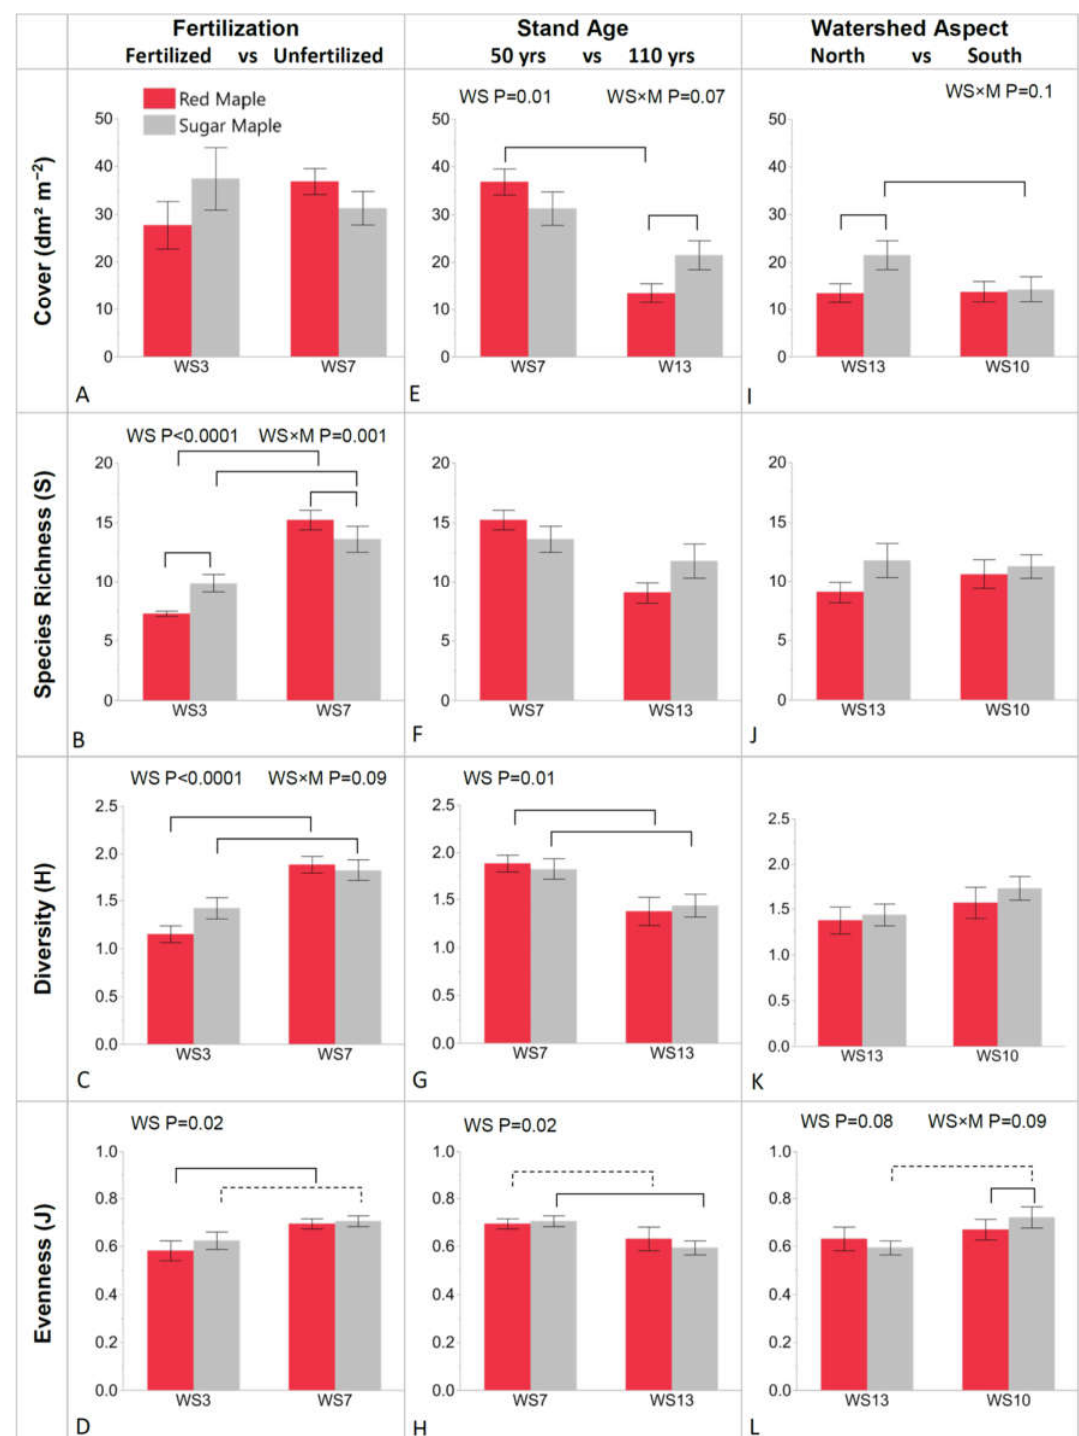
Figure 6. Herb-layer indices in red and sugar maple (M) plots in each of the studied watersheds (WS) at the Fernow Experimental Forest, West Virginia, USA, in the summers of 2018 and 2019. Watershed comparisons are: fertilized (WS3) vs. unfertilized (WS7) younger stands ( A – D ), younger (WS7) vs. older (WS13) unfertilized stands ( E – H ), and older unfertilized stands with northerly aspect (WS13) vs. southerly aspect (WS10) ( I – L ). If a horizontal bracket is connecting two means, the pairwise comparison (SAS slice effect) was significant at p ≤ 0.05 (solid bracket) or p ≤ 0.1 (dashed bracket). Error bars represent 1 SE based on nine plots per maple species per watershed, showing spatial variability within a watershed after respective plot-level values from 2018 and 2019 had been averaged. Statistical results are excerpts from the final ANOVA model (Table S3a), showing only factors WS, M, and WS × M if p ≤ 0.1.